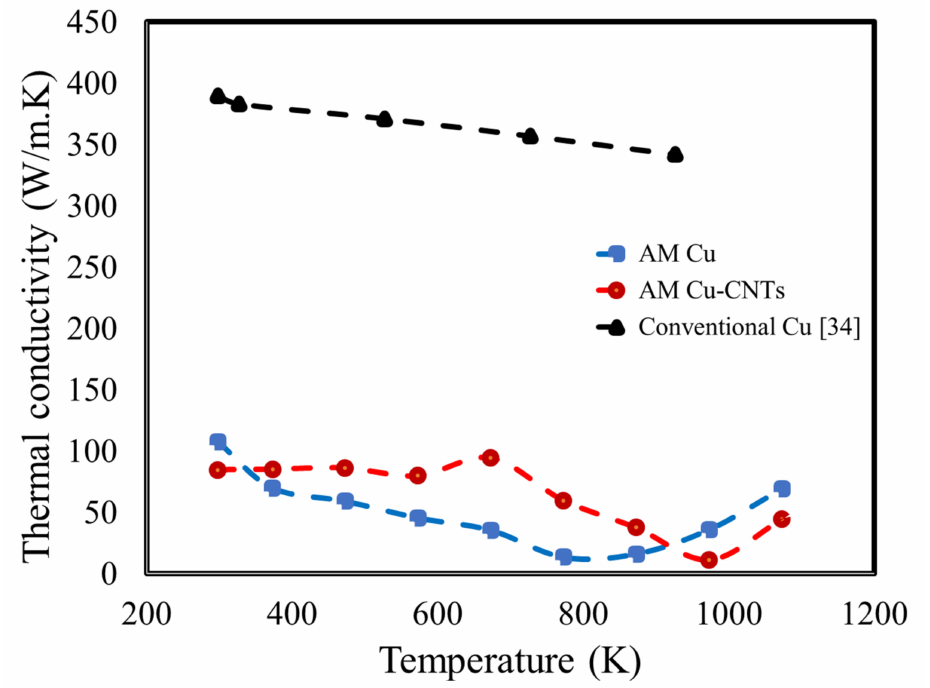
Figure 8. Thermal conductivity as a function of temperature for as-built Cu and Cu-CNTs as compared to conventionally fabricated Cu